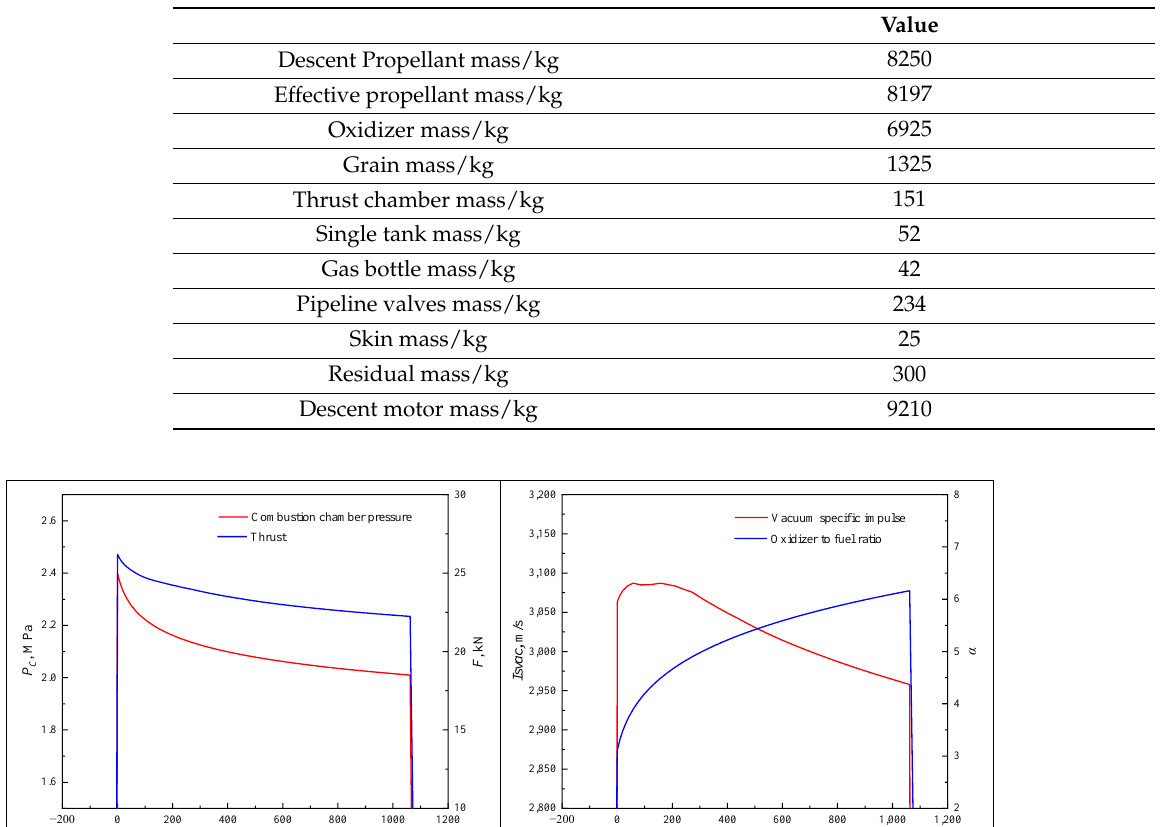
Table 8. The descent motor mass of HRM-TGGF.